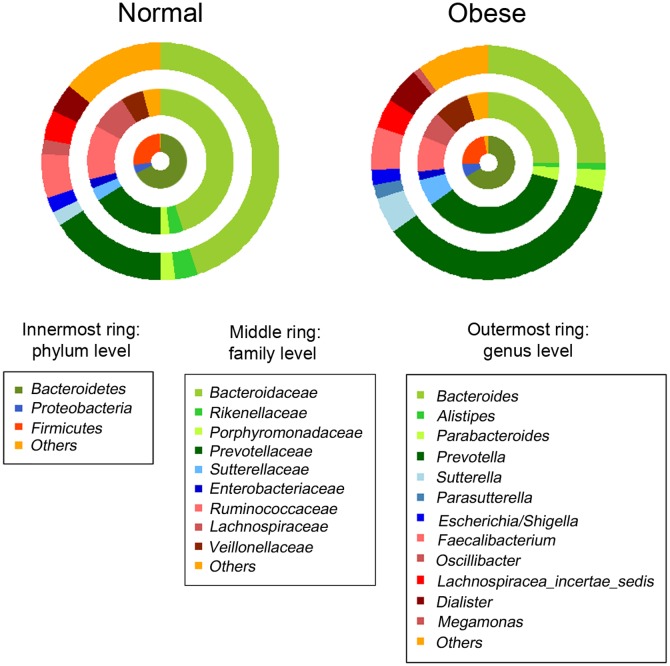
Average composition of the microbiota in fecal samples from normal and obese adolescents according to taxonomic rank.The innermost ring of the donut plots for both normal and obese individuals shows the composition at the phylum level, whereas the middle and outermost rings show the composition at the family and genus levels, respectively. There was a marked difference in the average proportions of Bacteroides and Prevotella between normal and obese samples at the genus level. This trend persisted at the family level. However, there were no significant differences in the Bacteroidetes, Firmicutes, and Proteobacteria populations in samples from normal and obese adolescents at the phylum level. All microbiota representing > 1% (mean value) composition are shown.